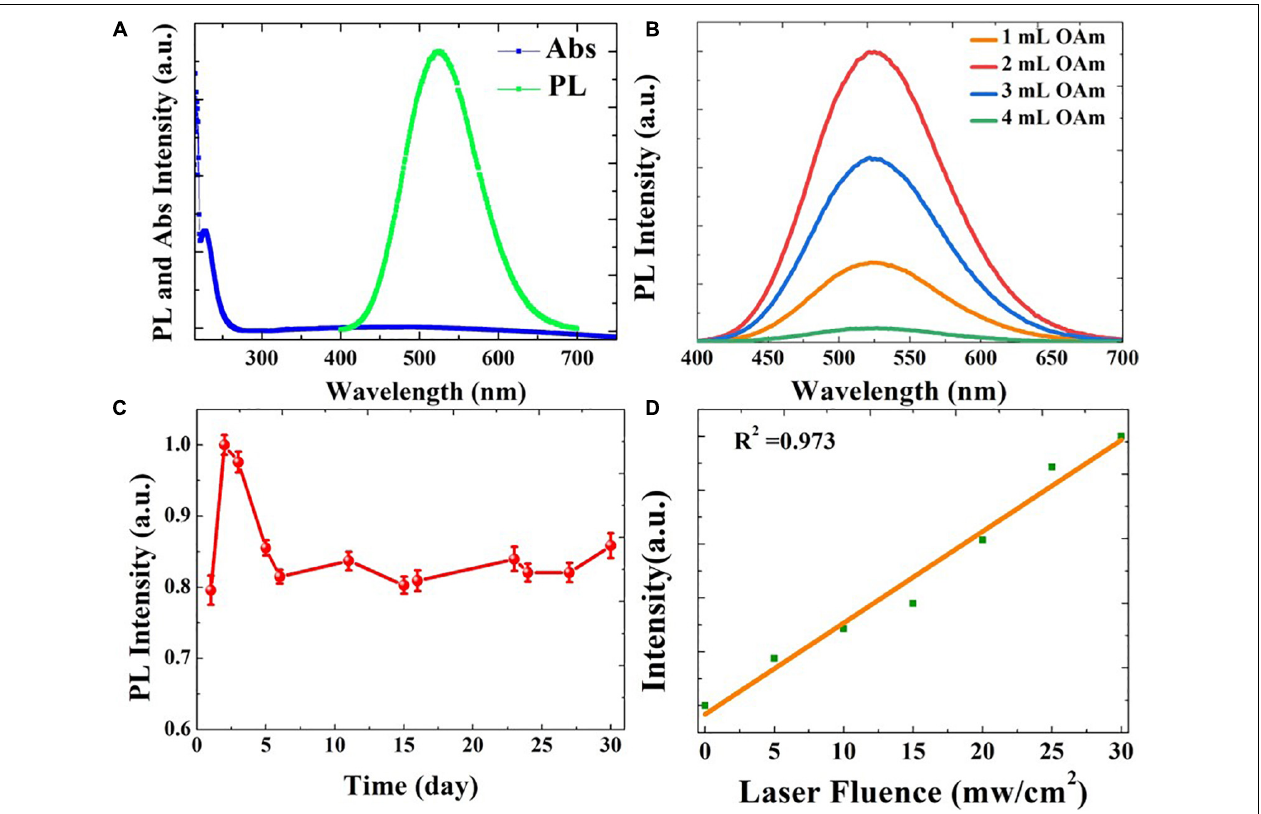
FIGURE 2 | (A) PL and absorption spectra of Cs 3 Cu 2 Cl 5 NCs solution. (B) PL spectra of different quantities of OAm-capped NCs. (C) Air-stability test of Cs 3 Cu 2 Cl 5 NCs. (D) Dependence of the emission intensity in Cs 3 Cu 2 Cl 5